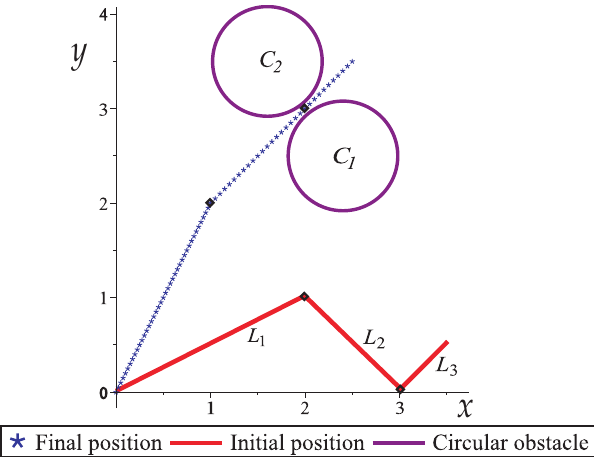
Figure 9. Workspace of a planar robot arm with three links and two circular obstacles.